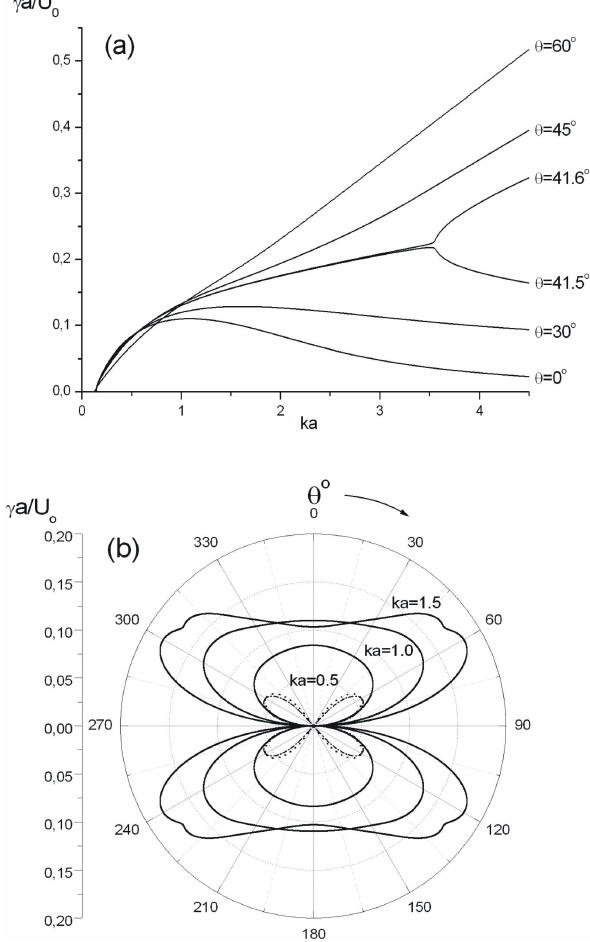
Fig. 13. (a) The growth rate γa/ U 0 as a function of ka for var- ious angles θ of wave propagation. Plasma densities in all three regions are taken different ρ 01 /ρ 0 f = 0 . 8, ρ 02 /ρ 0 f = 1 . 2. Other = 0 . 001, c 2 = c 2 = 0 . 01 and / U 2 / U 2 / U 2 parameters are c 2 S 1 s 2 0 0 S f 0 v A f / U 0 = 0 . 316; (b) Polar plots of the normalized growth rate γa/ U 0 as a function of θ for fixed ka . Solid curves represent the growth rates calculated for the three-layered plasma. Dashed and dot-and-dash curves show γa/ U 0 calculated for two semi-infinite plasmas. Dashed curves are related to the boundary between the region 1 and flow, and dot-and-dashed lines – to the boundary be- tween the region 2 and